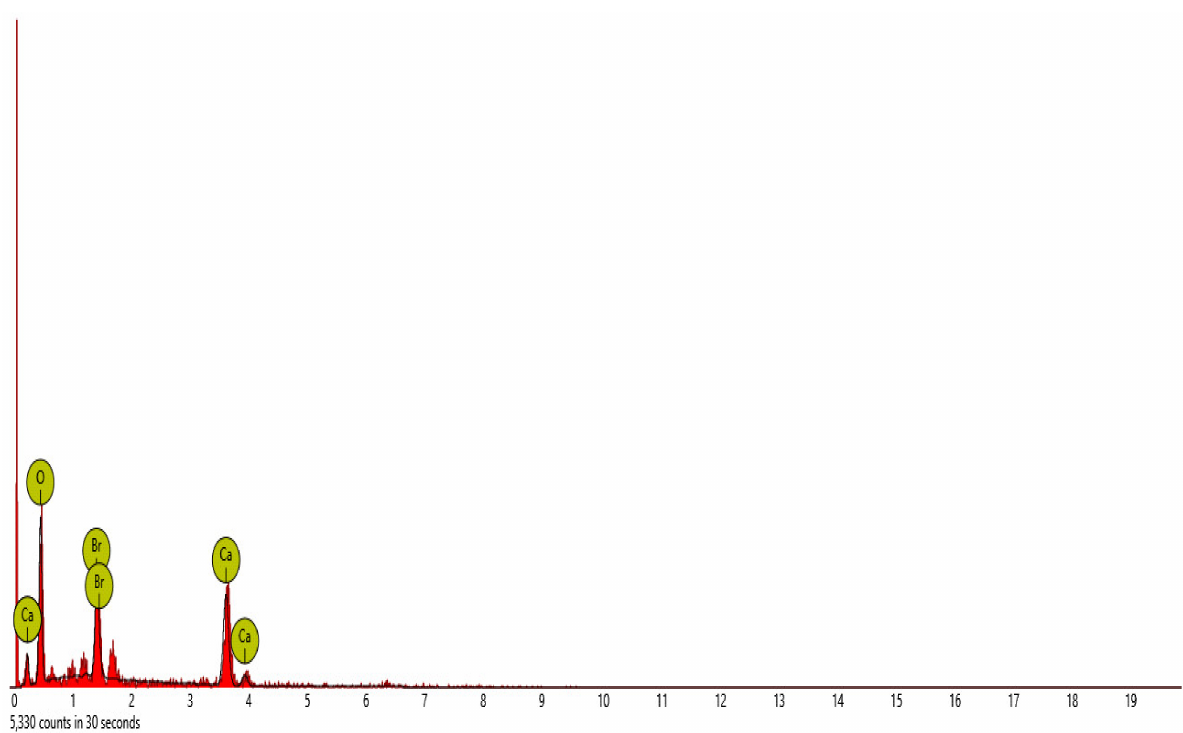
Figure 16. Graphical charts illustrating the atomic quantifications and weights of the elements discovered from the EDS spectra of pervious concrete spot 2 sample Y 1 .